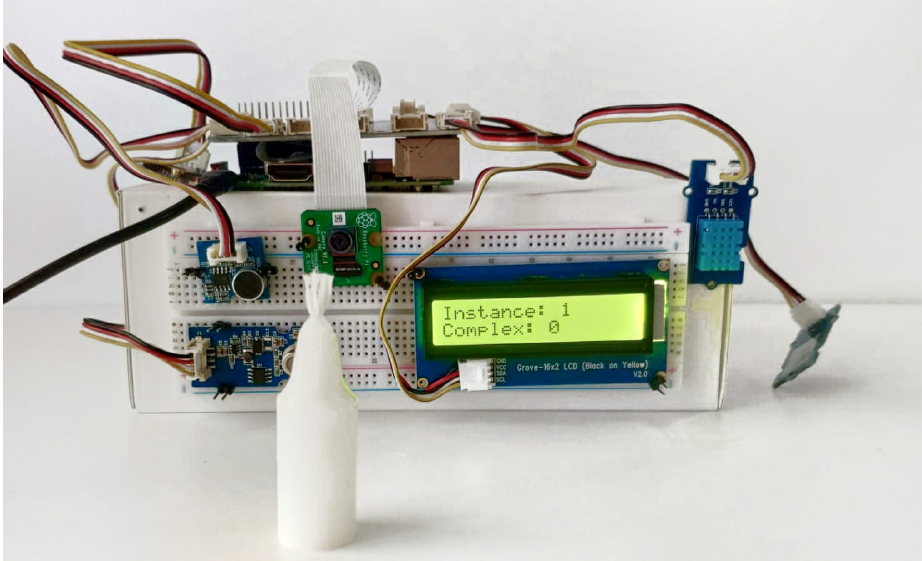
Figure 5. The experimental EDU when detecting 1 instance event